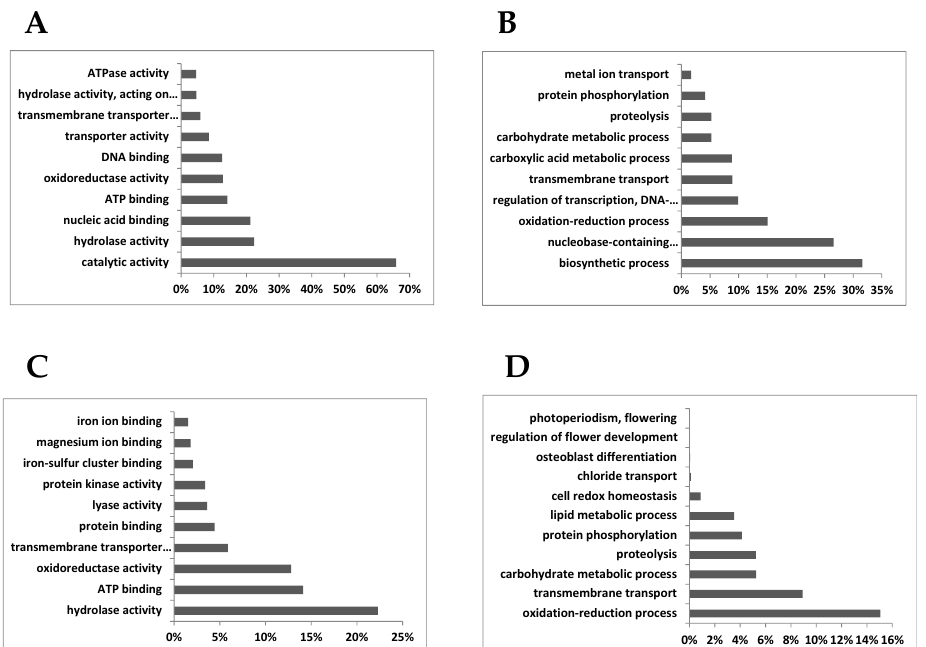
Figure 1. Gene enrichment analysis of shoot and root DEGs. ( A) : root, molecular function; ( B) : root: biological process; ( C ): shoot, molecular function; ( D ): shoot, biological process. The 10 most abundant Gene ontology (GO) terms found in the root and shoot DEGs are represented as the percentage over the total GO terms found in the analysis. Table 1. Genes upregulated in roots of L. japonicus plants growing under purely symbiotic conditions (Nod plants) compared to roots of L. japonicus plants growing under non-symbiotic conditions and supplied with ammonium nitrate (NN) plants. The fold change (FC) in expression levels is expressed as the log 2 of the di ff erence in relative expression levels of Nod–NN. When two di ff erent gene codes are reported, it means that both of them were recognized by the probeset due to very high homology. Genes without a previously proposed role in nodule function and / or development are highlighted with two asterisks. Italic font is used to highlight the genes that belong to the secondary (smaller) cluster according to the analysis carried out (left cluster in Figure 4). Genes that cluster together with known L. japonicus regulatory genes are highlighted in bold.